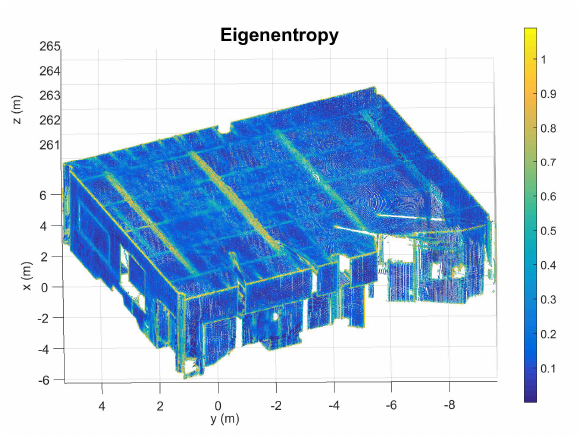
Figure 1. Classroom point cloud coloured with the eigenentropy values.